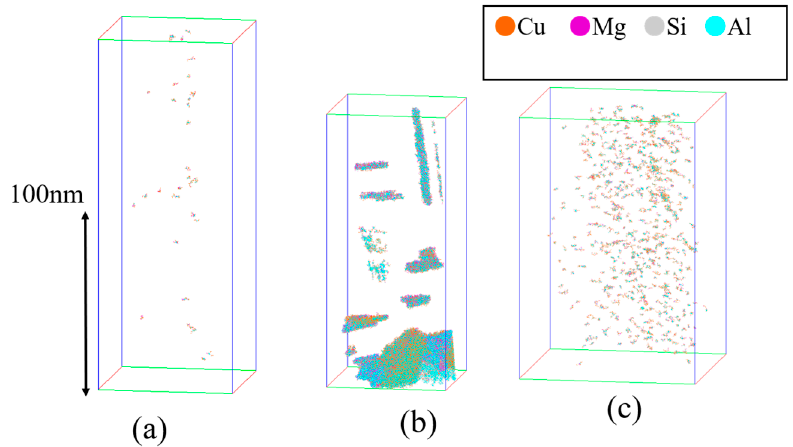
Figure 11. Atom probe elemental mapping for ( a ) solution-annealed and quenched specimen, ( b ) specimen aged at 423 K for 4 days, and ( c ) specimen irradiated with iodine ions to the fluence of 1 × 10 15 / cm 2 at room temperature.